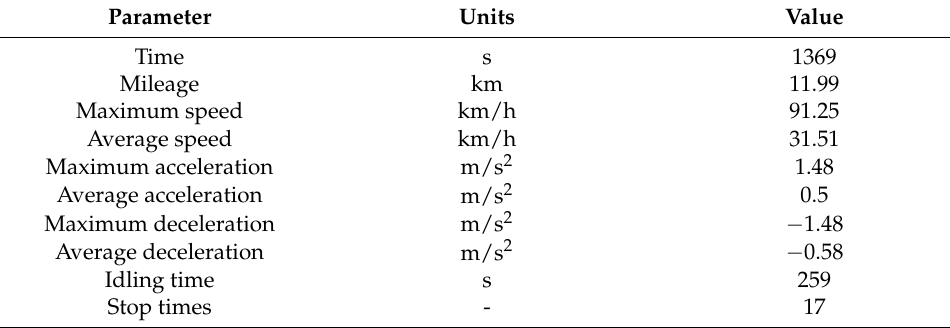
Table 3. Specific characteristics of the UDDS